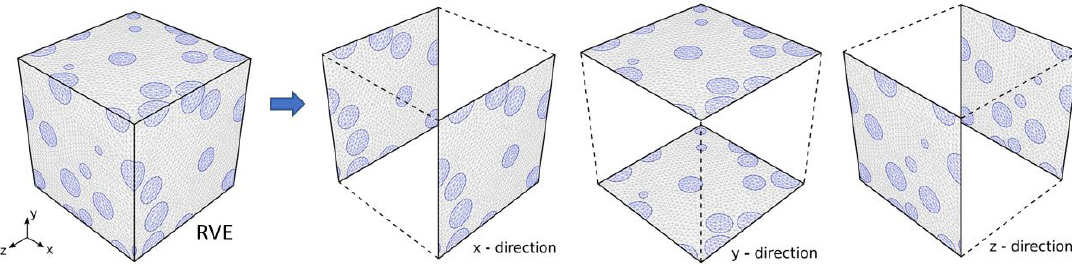
Figure 8. Periodic meshes between opposite sides of a cubic